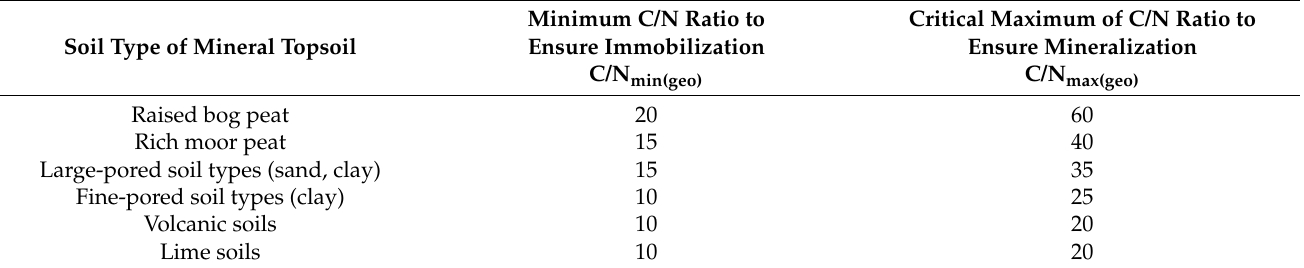
Table 14. Critical minima and maxima of C/N ratios to ensure a long-term balance of immobilization and mineralization in humus